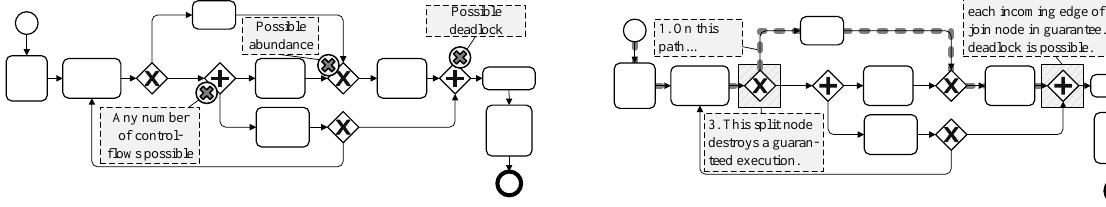
Figure 25. An overview of faults with Mojo Figure 26. Detailed fault feedback of the cause